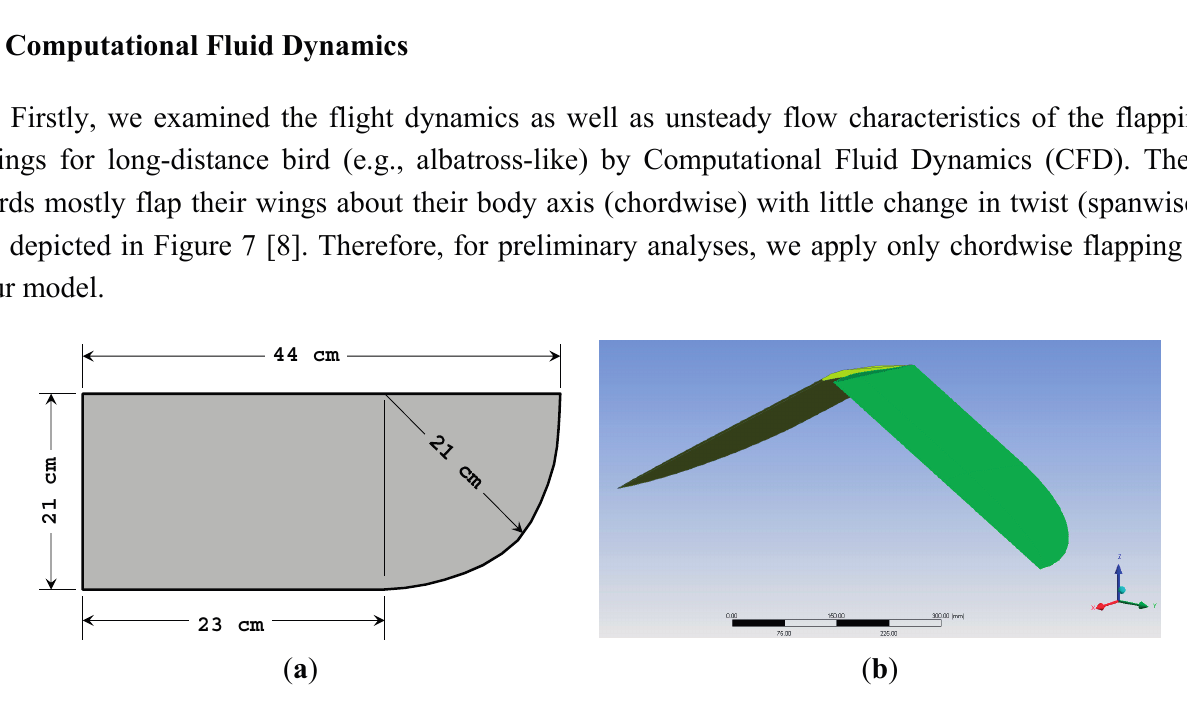
Figure 6. Concept of resonance-type flapping mechanism [7].